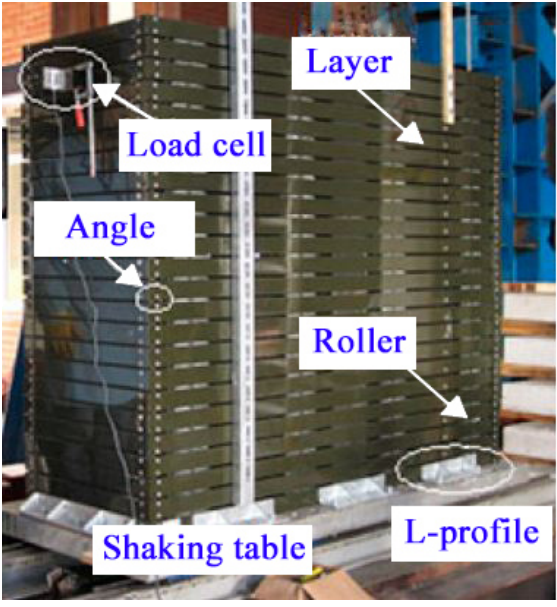
Figure 8. General view of the laminar box (From [25]; modified).